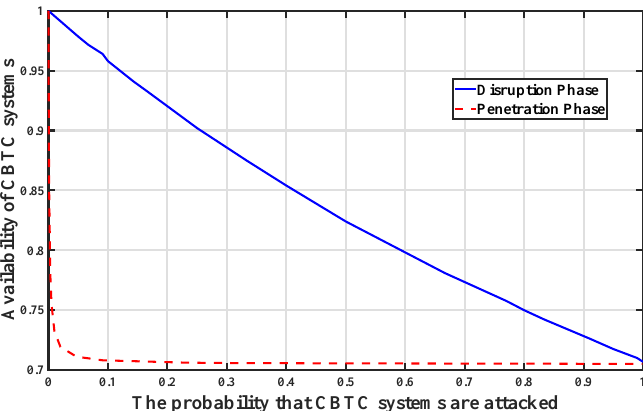
Figure 8. CBTC availability with attack action